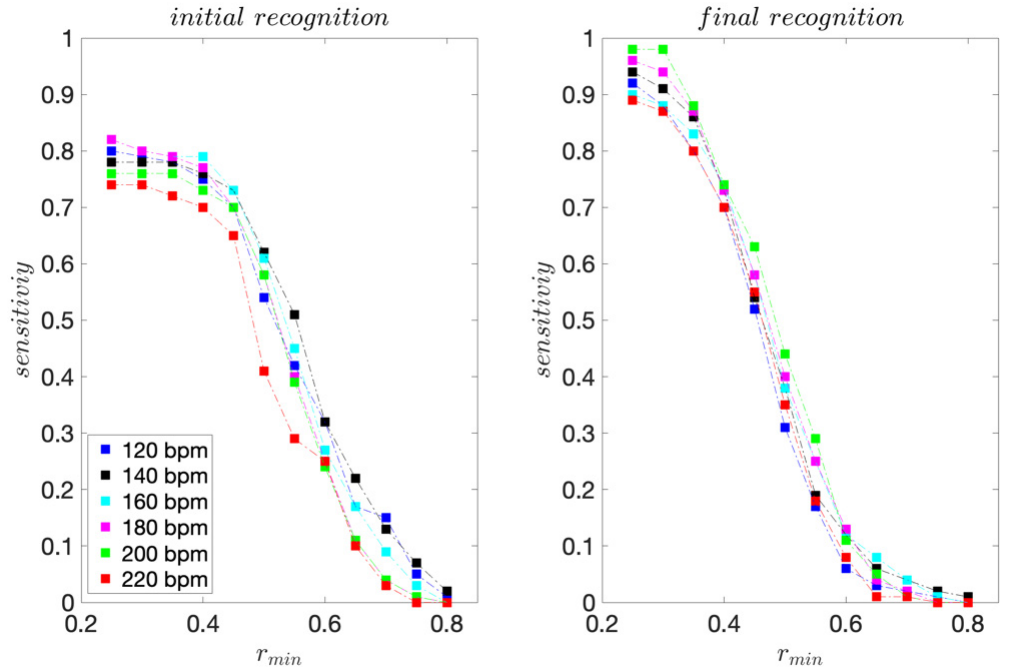
Figure 6. Sensitivity scores obtained for the recreational dancers’ test sequences.